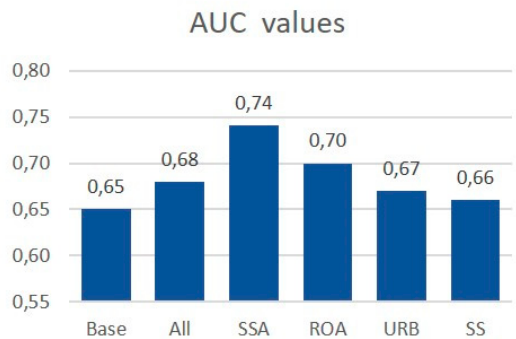
Figure 4. AUC (area under receiver operating characteristic curve) values of di ff erent configurations.